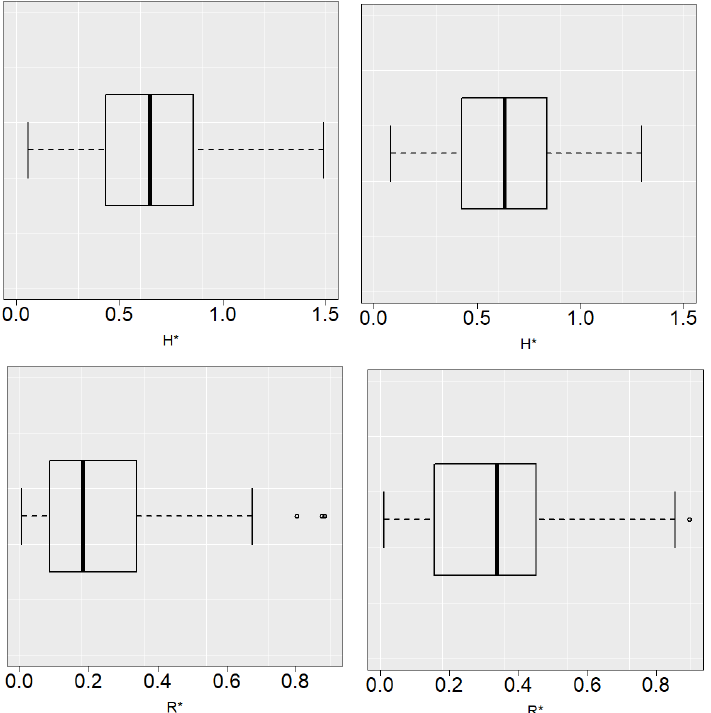
Figure 5. Boxplot of H ∗ conditional probability of censoring is 0.2 ( left ) and 0.5 ( right ) in Model